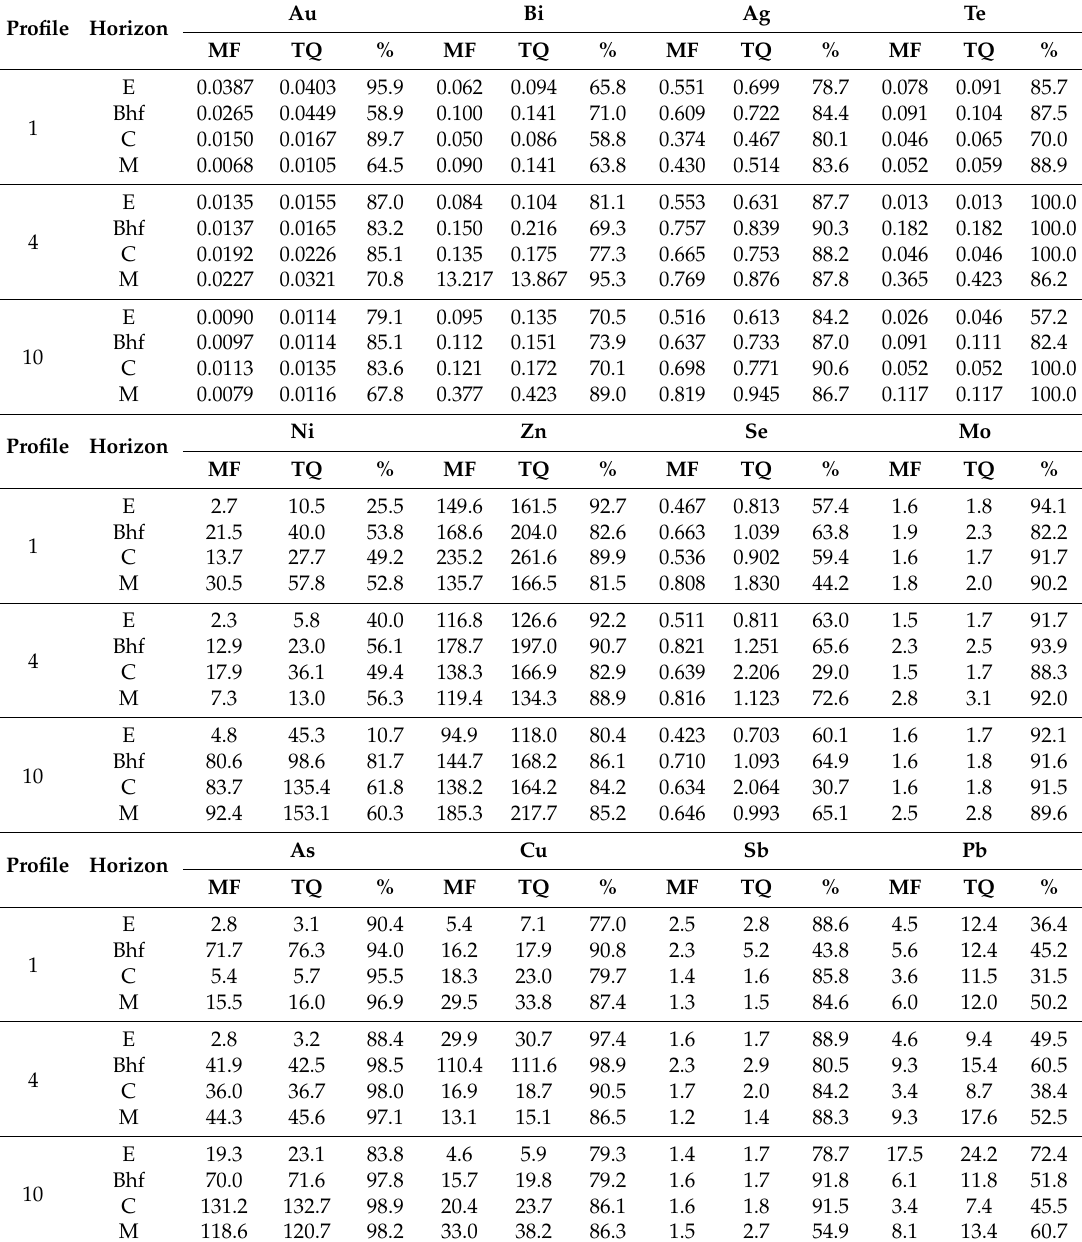
Table 6. Percentages of mobile forms of elements in surface sediments in the Piilola area. MF—mobile form (ppm); TQ—total quantity (sum of element concentration in all extracts, ppm); %—mobile form percentage from the total